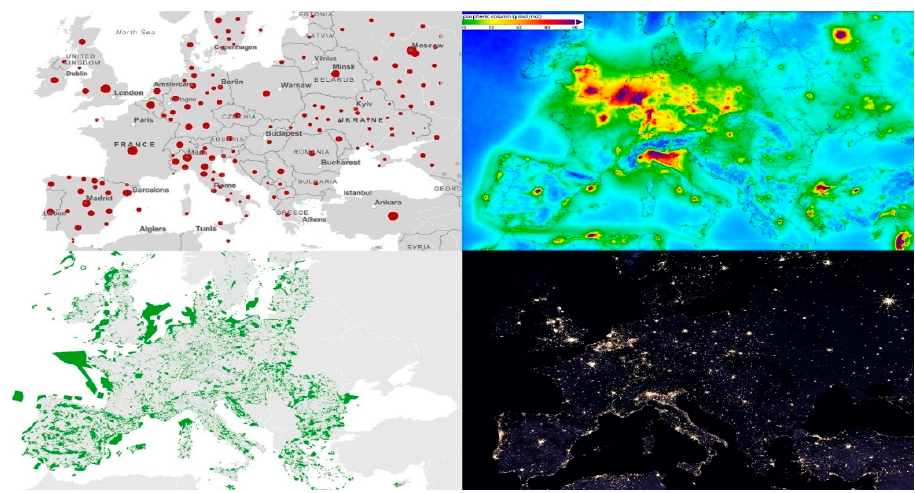
Figure 1. The figure presents a double territorial interpretation: geographical coincidence between major urban and peri-urban areas, pollution distribution and COVID-19 contamination; geographical coincidence between natural areas rich in biodiversity, less pollution distribution and less COVID-19 contamination (a reworking of Ilenia Pierantoni on the base of: top, left : EU map of COVID-19 Cumulative confirmed cases—Source: processing Ilenia Pierantoni on COVID-19 Dashboard by the Center for Systems Science and Engineering (CSSE) at Johns Hopkins University (JHU); top, right : Nitrogen dioxide map distribution, Source: European Environmental Agency; below, left : Distribution of the Natura 2000 protected areas network in Europe, Source: processing Ilenia Pierantoni on EEA database. below, right : European Night Lights Maps, “Earth at night, ”Source: NASA Earth Observatory images by Joshua Stevens, using Suomi NPP VIIRS data from Miguel Rom á n, NASA’s Goddard Space Flight